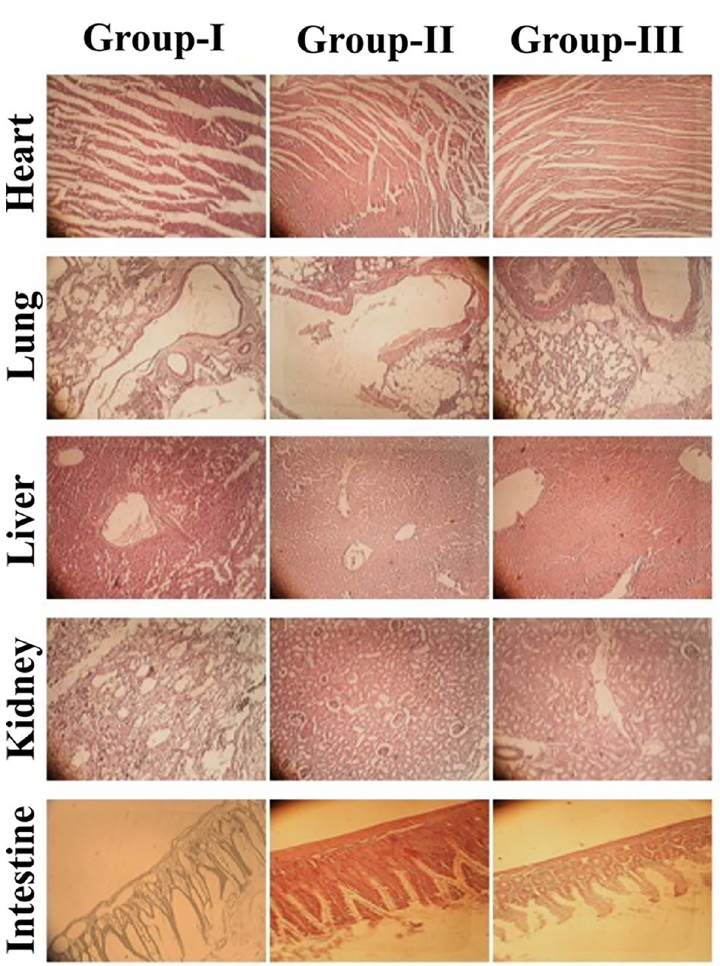
Fig 7. Histopathological microscopic examination of different tissues of Wistar rats of group-I (control), group-II (test) and group-III (test).